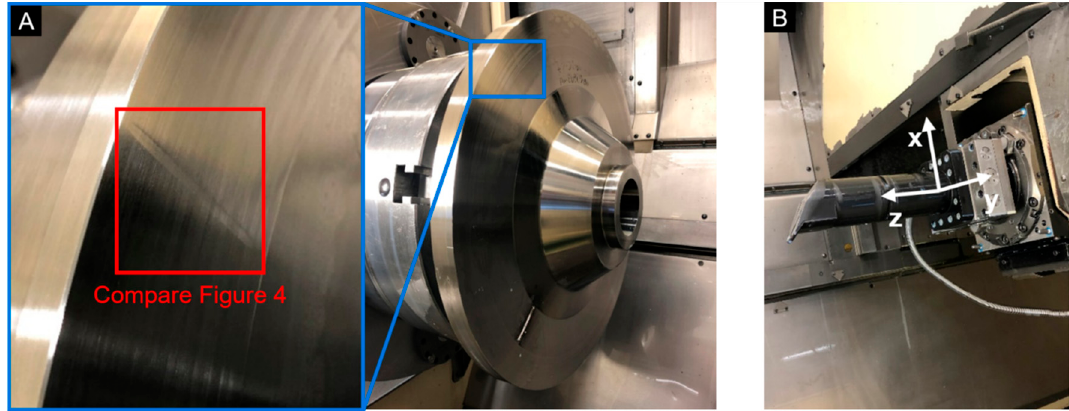
Figure 3. Experimental setup for turning processes with the workpiece ( A ) and the tool setup for force measurement ( B ). Table 2. Evaluated parameter values of the turning experiments.